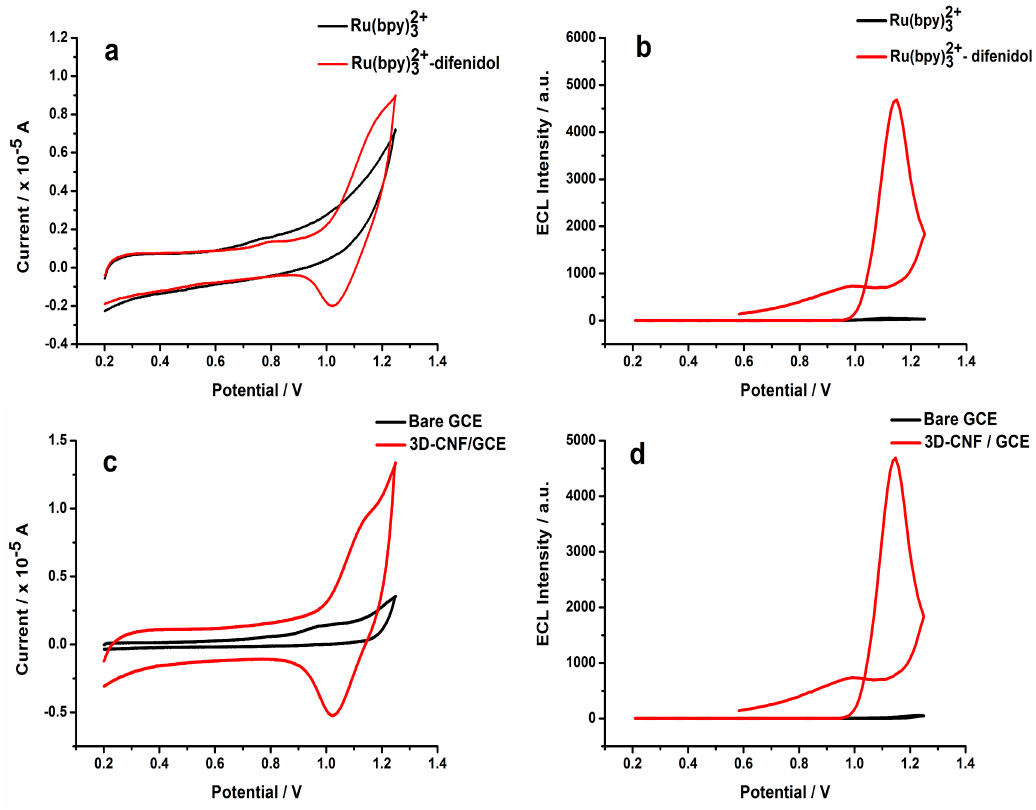
Figure 4. EC ( a ) and ECL ( b ) curves of Ru(bpy) 32+ and Ru(bpy) 32+ -difenidol hydrochloride in a 0.1-mol·L − 1 borate buffer solution (pH 7.5), and EC ( c ) and ECL ( d ) curves of Ru(bpy) 32+ -difenidol hydrochloride in a 0.1-mol·L − 1 BBS solution (pH 7.5) on a bare GCE and a 3D-CNF GCE, respectively.